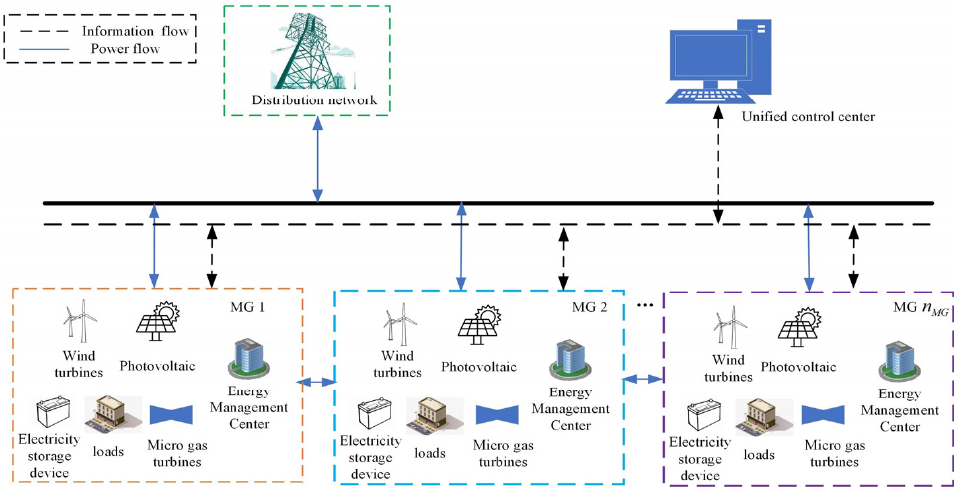
Figure 2. Schematic diagram of the MMG structure.